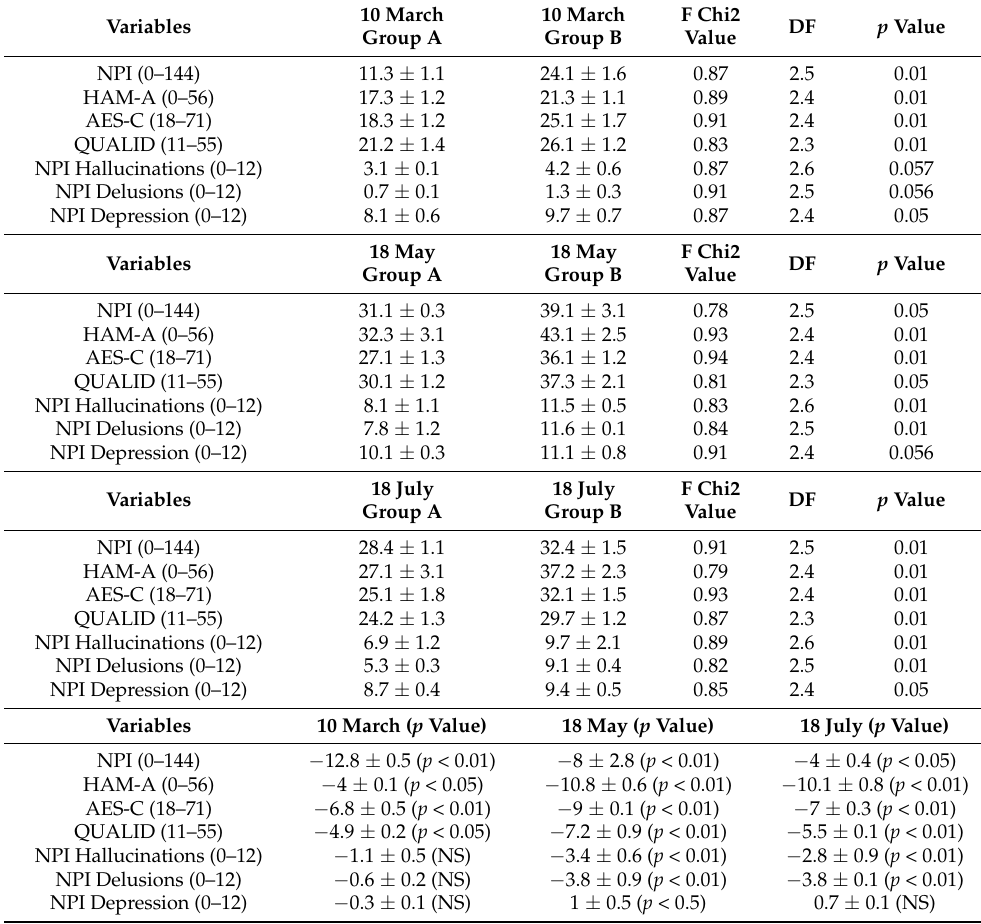
Table 6. Comparison of mean value and SD to compare the longitudinal changes of variables between group A and